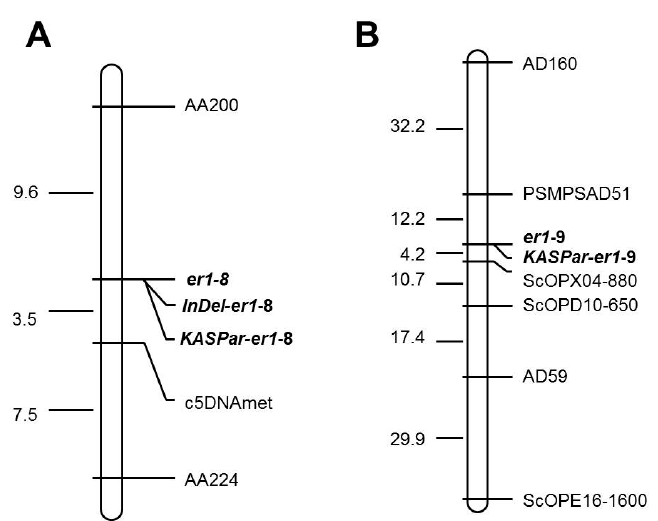
Figure 3. Genetic linkage maps constructed using the er1 -linked markers and the functional markers for er1 -8 and er1 -9, based on the F 2 populations derived from ( A ) WSU 28 × G0004389 and ( B ) Bawan 6 × G0004400. Map distances and loci order were determined with MAPMAKER v3.0 (Lander et al. 1993). Estimated genetic distances between loci are shown to the left of the maps in centiMorgans (cM).